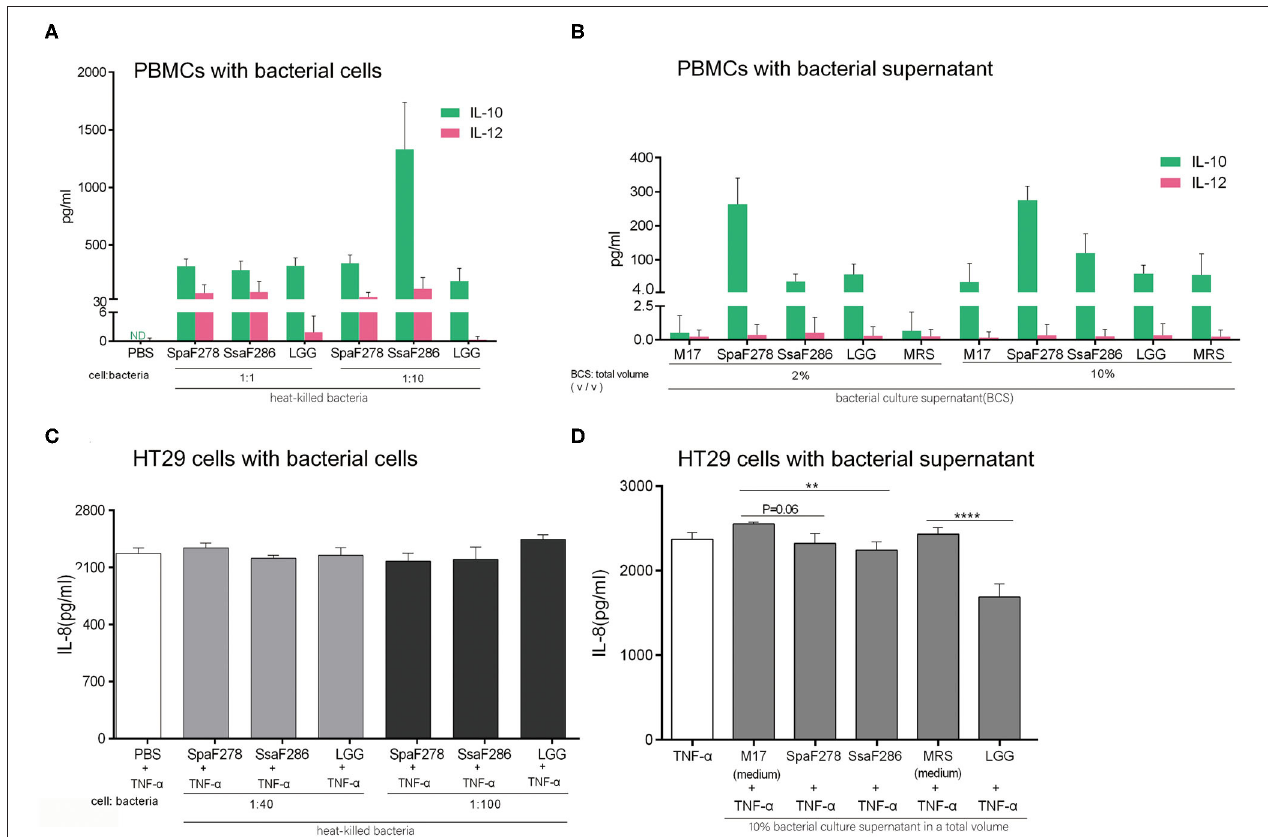
FIGURE 5 | S. salivarius F286, S. parasanguinis F278 and LGG exhibited anti-inflammatory capacity in in vitro assays with human PBMCs and TNF- α -treated gut epithelial HT29 cells. (A,B) Anti-inflammatory IL-10 and pro-inflammatory IL-12 production by PBMCs stimulated with heat-killed bacterial cells (A) and culture supernatants (B) of individual bacterial strains for 24h. Data are expressed as the mean ± SD of the results of the assays of 5 and 7 healthy blood donors for the bacterial cells and supernatants, respectively. (C,D) The effects of heat-killed bacterial cells (C) and culture supernatants (D) of individual bacterial strains on IL-8 production by HT29 cells treated with 5ng/ml TNF- α . Data are represented as the mean ± SD of at least triplicate measurements, and differences were compared with Student’s t- test. ** p < 0.01; **** p < 0.0001. PBS, phosphate buffered saline. M17, the unfermented sterile bacterial growth medium for S. salivarius F286 and S. parasanguinis F278. MRS, the unfermented sterile bacterial growth medium for